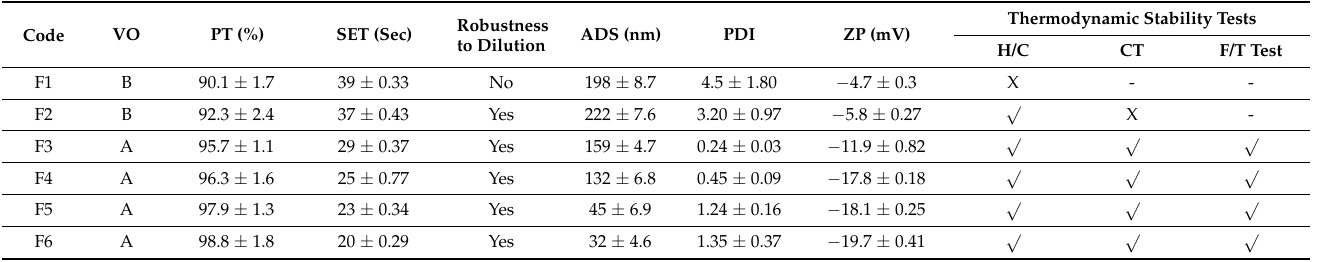
Table 4. Characterization of tadalafil-loaded liquid self-nanoemulsifying drug delivery systems (TDL-L-SNEDDS) formulations.